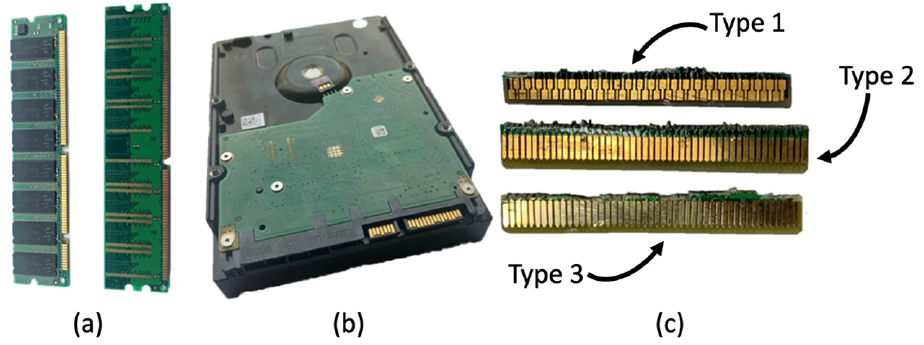
Figure 1. Macroscopic features of the received WEEE sample: ( a ) RAM; ( b ) HD; ( c ) Varieties of con- tacts from RAM and HD as received.